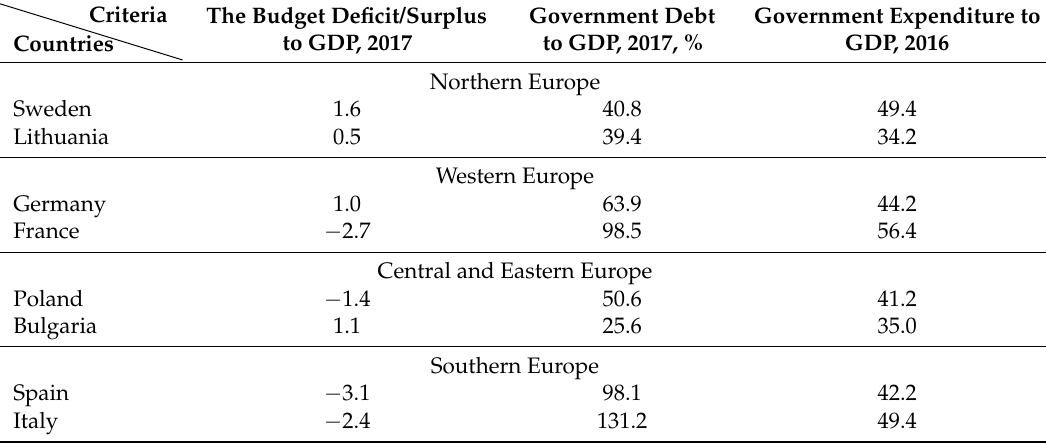
Table 6. Values of macroeconomic